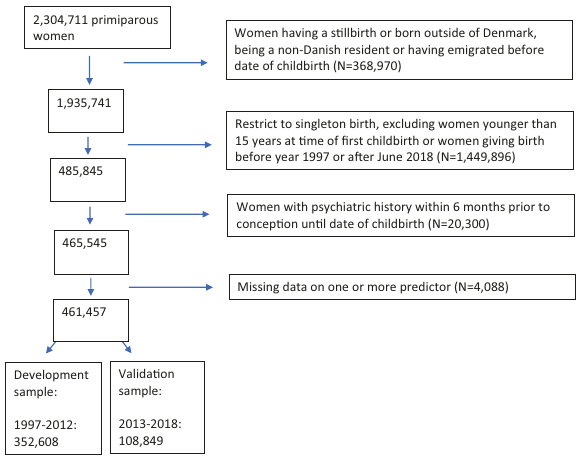
Fig. 1 Study population